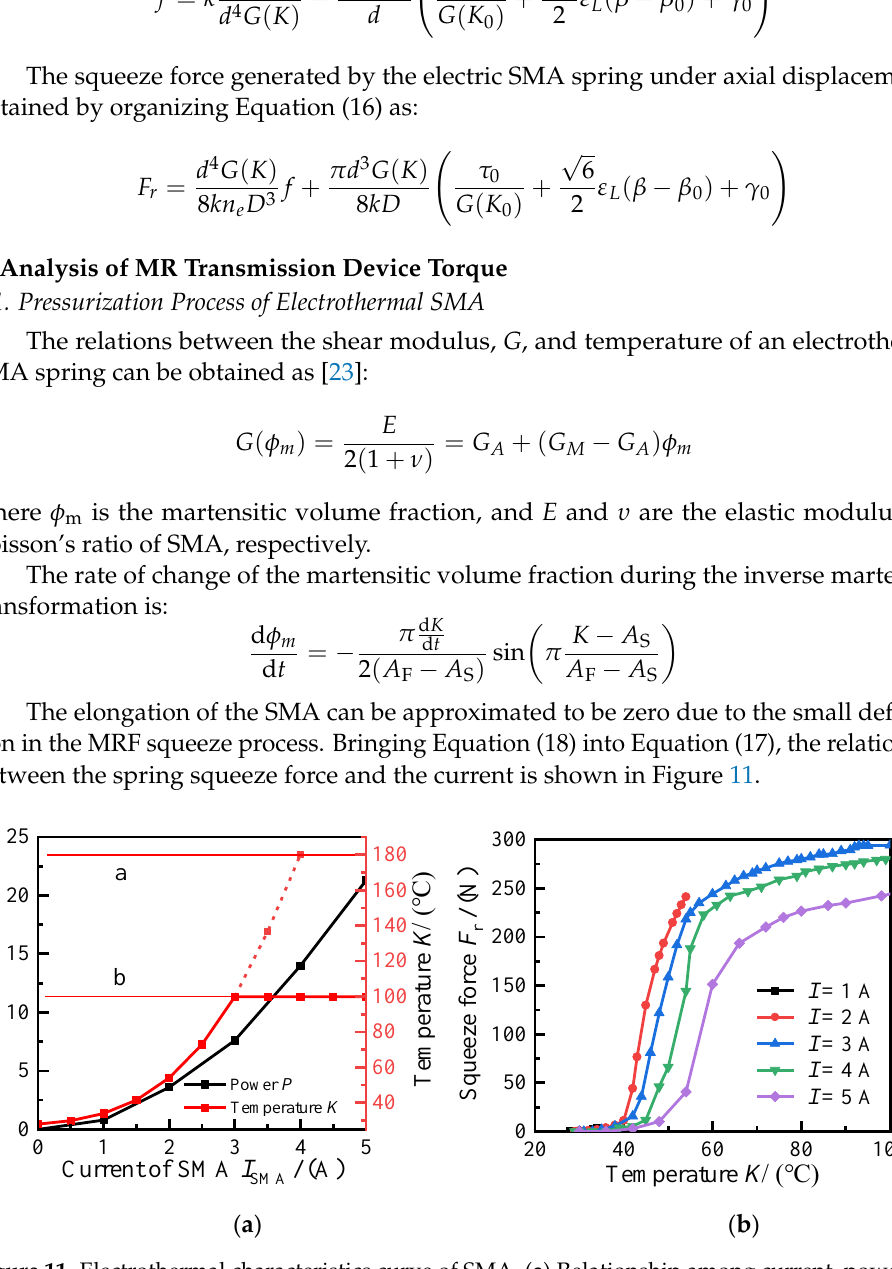
Figure 11. Electrothermal characteristics curve of SMA. ( a ) Relationship among current, power, and spring temperature. ( b ) Relationship between squeeze force and temperature. The solid line in the current versus temperature curve in Figure 11a represents the actual recorded test data, while the dashed line shows theoretical current versus